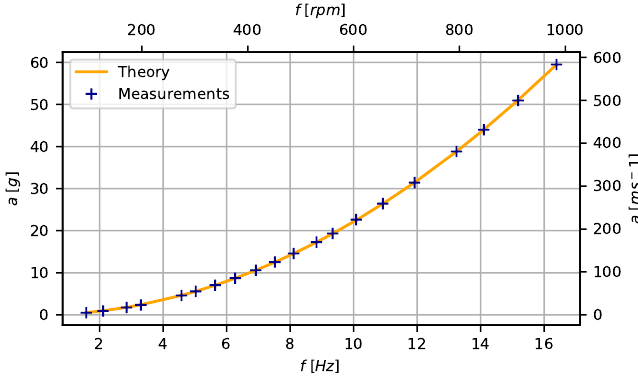
Figure 9: Centrifugal acceleration versus angular frequency in theory and in our experi- ments. Experimental measurements are shown after correction for offset and scale error. Above 300 rpm, the relative error is below 0 . 5 %. Below 300 rpm, the residual offset error has a large impact (0 . 05 g absolute or 8% relative at 95